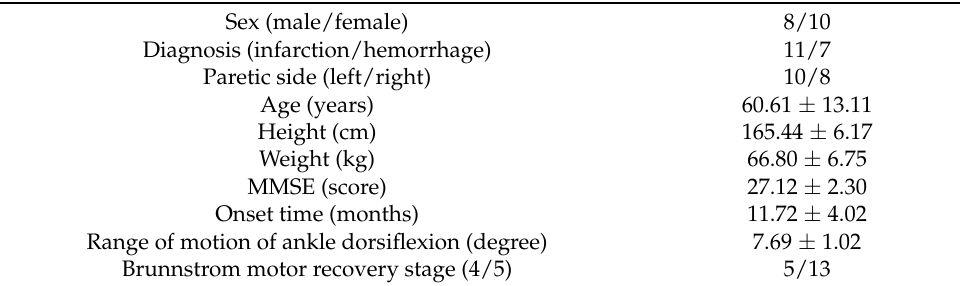
Table 1. Baseline characteristics of the participants ( n = 18).